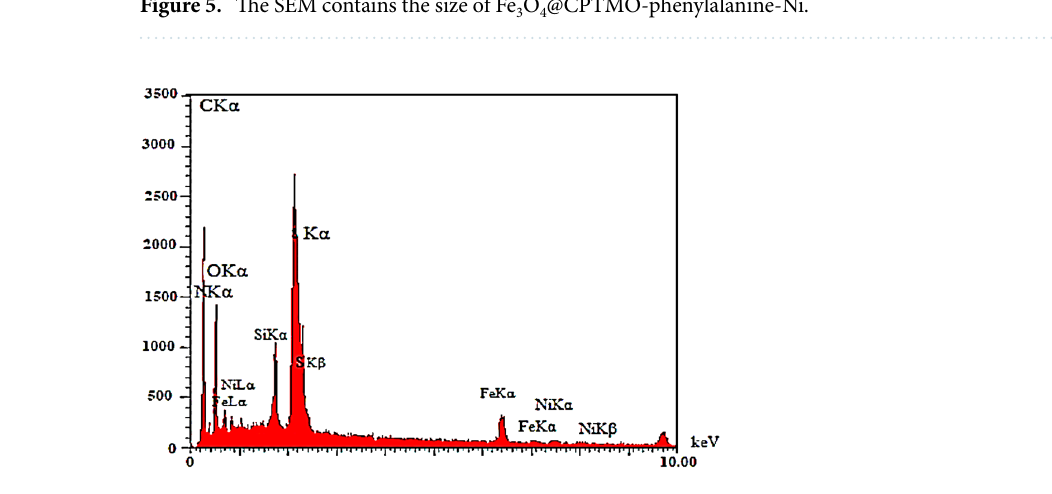
Figure 6. EDS analysis of Fe 3 O 4